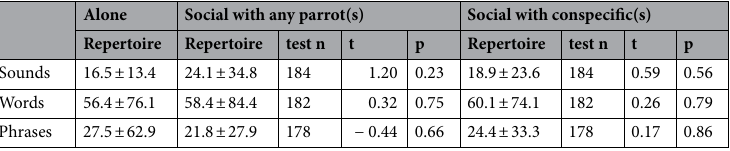
Table 4. Mean repertoire sizes (± SD) and results of t-tests comparing repertoire sizes in grey parrots that do and do not interact socially with other parrots.